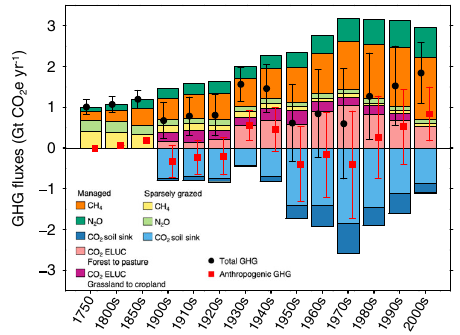
Fig. 2 The decadal greenhouse gas (GHG) fl uxes of global grassland during the period 1750 – 2009. Light and dark blue bars represent CO 2 fl uxes from managed and sparsely grazed grassland, respectively; orange and yellow represent CH 4 fl uxes from managed (domestic livestock) and sparsely grazed (wild grazers) grassland, respectively; light green and dark green represent N 2 O fl uxes from managed and sparsely grazed grassland, respectively; and pink and purple represents land-use change emissions related to grassland from deforestation to pasture and from conversion of grassland to cropland, respectively. Black dots and their error bars indicate net total GHG balance and its 1-sigma uncertainty. Red squares and their error bars indicate the anthropogenic GHG balance after subtracting pre-industrial GHG fl uxes. Negative values indicate GHG sinks and positive values indicate GHG